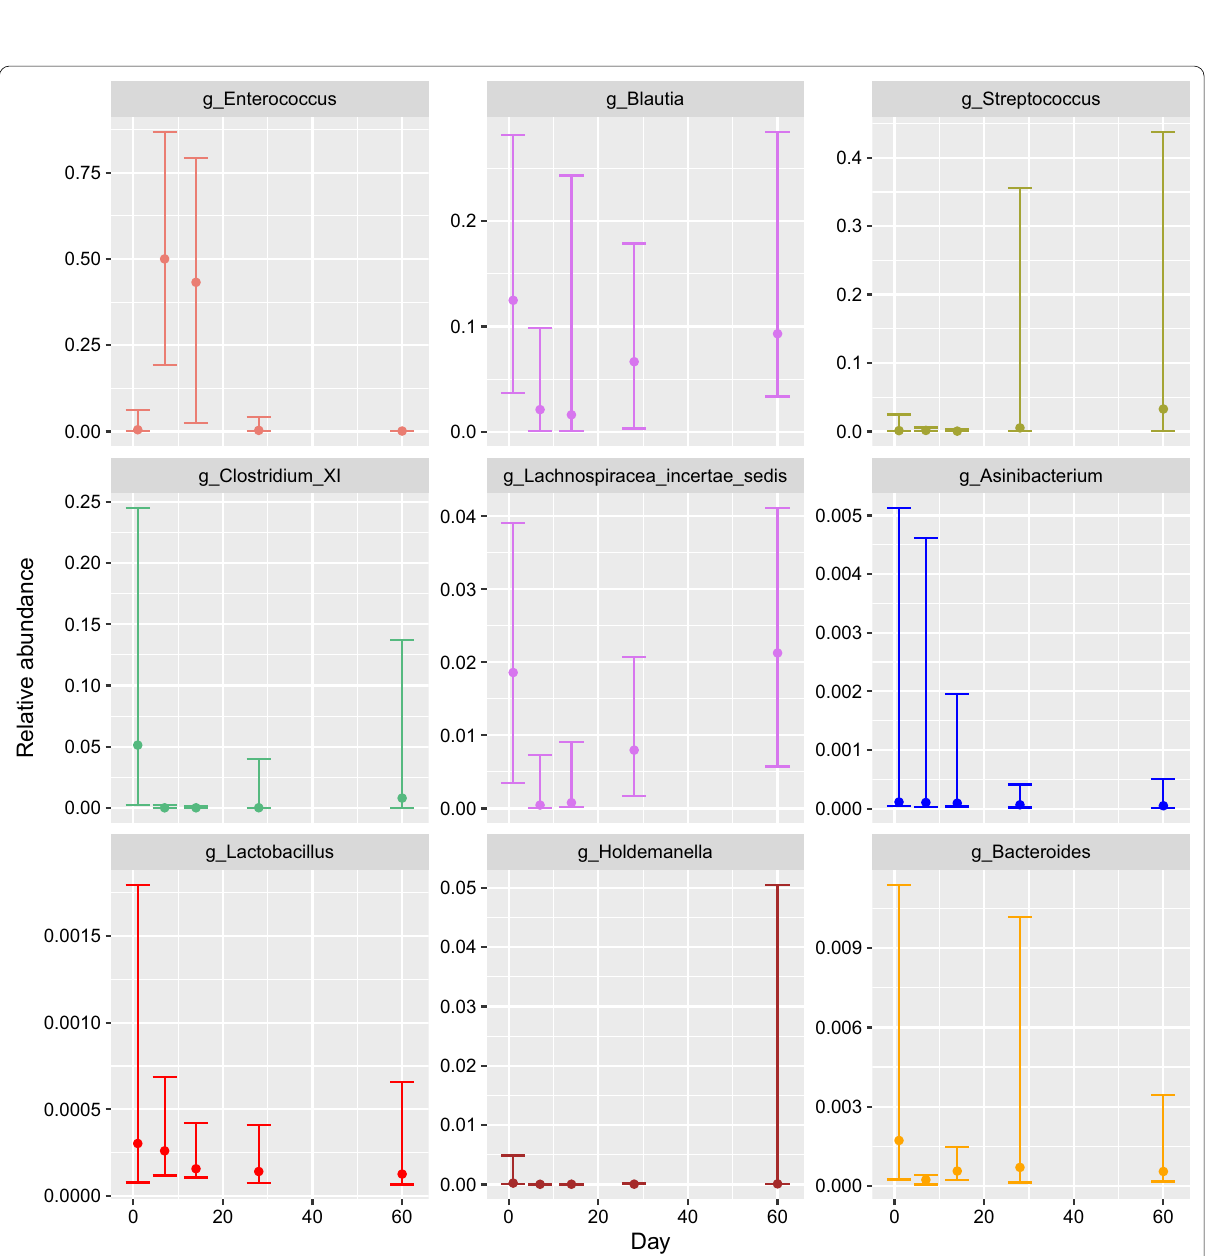
Fig. 9 Changes in relative abundance of nine most abundant bacterial genera over time. Points bars represent the median relative abundance and interquartile